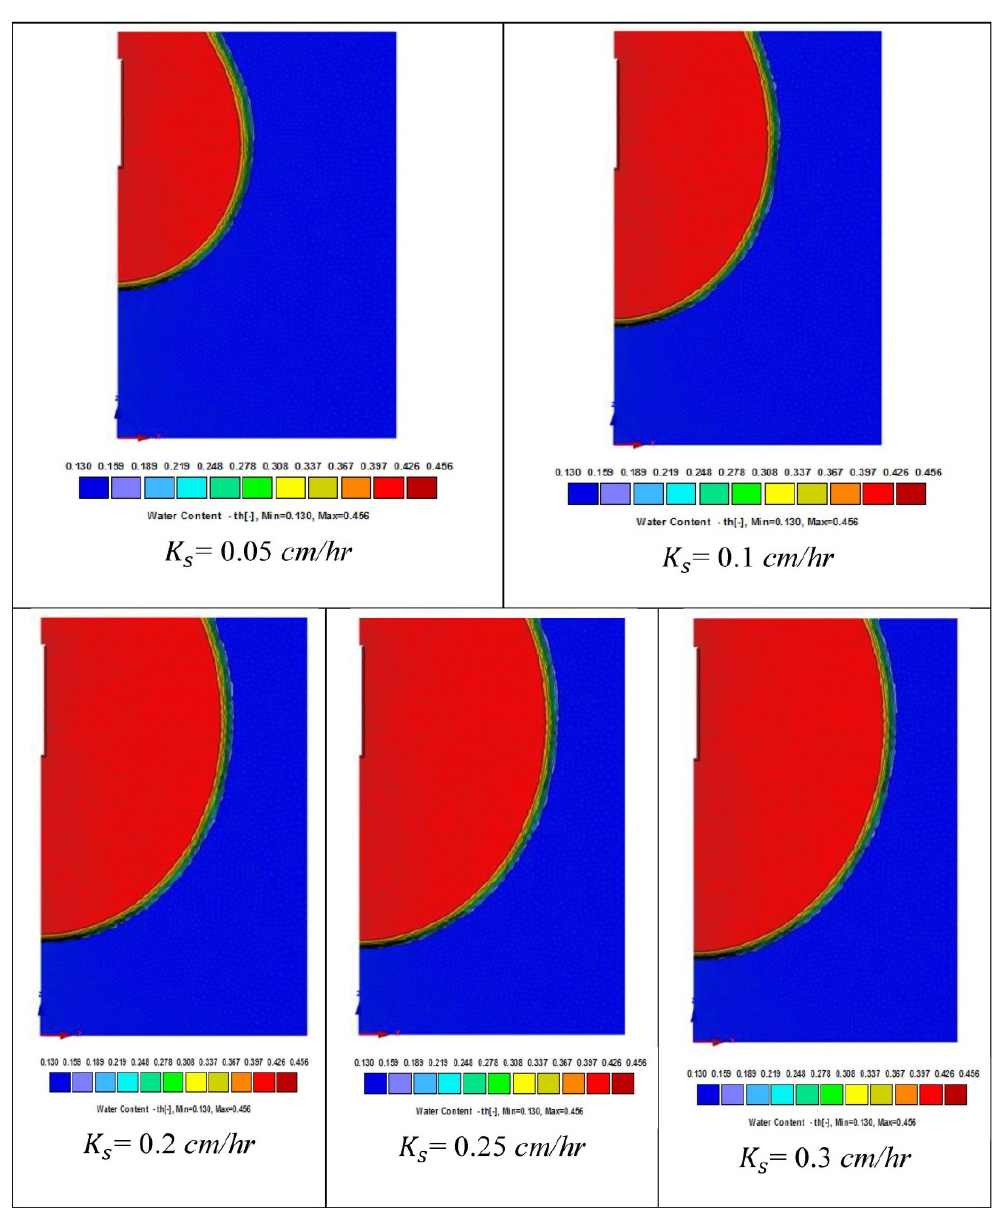
Fig. 4. Simulation of wetting patterns from a ceramic pipe in sandy loam soil with 1.0 x1.5 m domain, pipe length= 40 cm, initial soil water content= 0.13 cm 3 /cm 3 , applied head =200 cm, and with different pipe hydraulic conductivities after 1.5